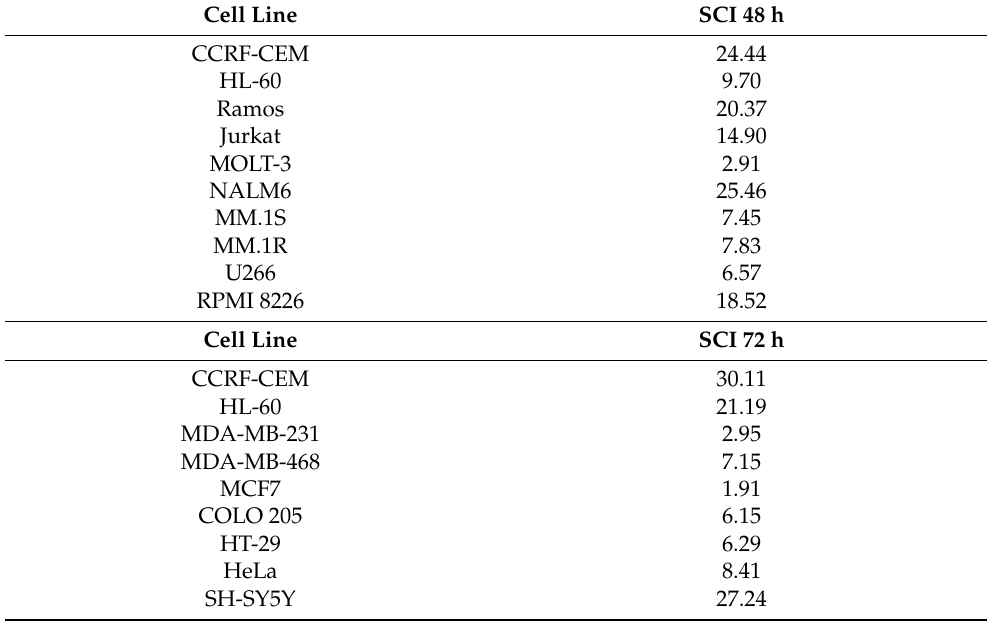
Table 2. Selective cytotoxicity index (SCI) values of Tpz-1 in 17 cancer cell lines at 48 h (top) and 72 h (bottom) of